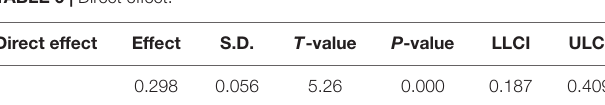
TABLE 9 | Results of the conditional indirect effect (moderation effect of EEC between RL and OCBE).